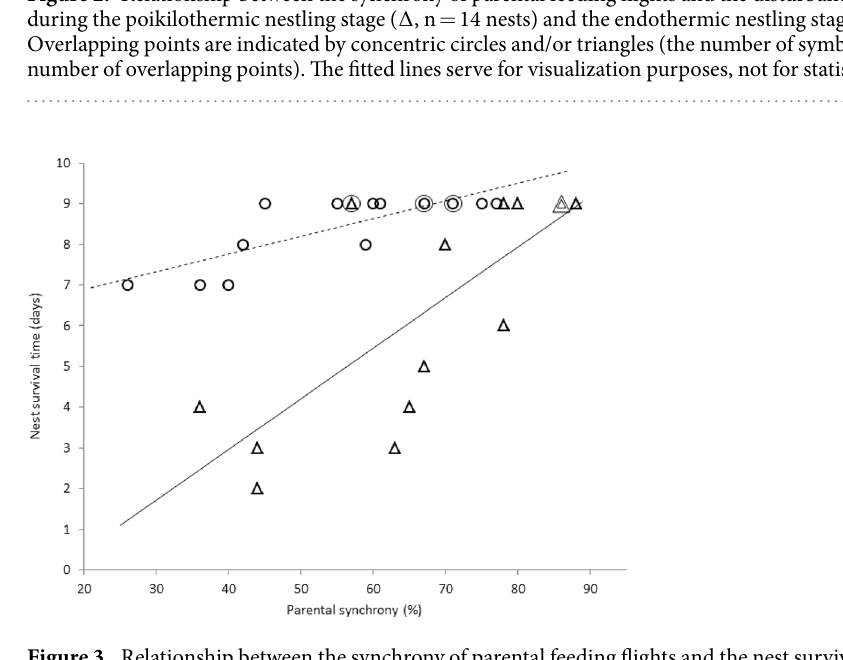
Figure 3. Relationship between the synchrony of parental feeding flights and the nest survival time during the poikilothermic nestling stage ( ∆ , n = 14 nests) and the endothermic nestling stage ( ○ , n = 16 nests). Overlapping points are indicated by concentric circles and/or triangles (the number of symbols represents the number of overlapping points). The fit lines serve for visualization purposes, not for statistical